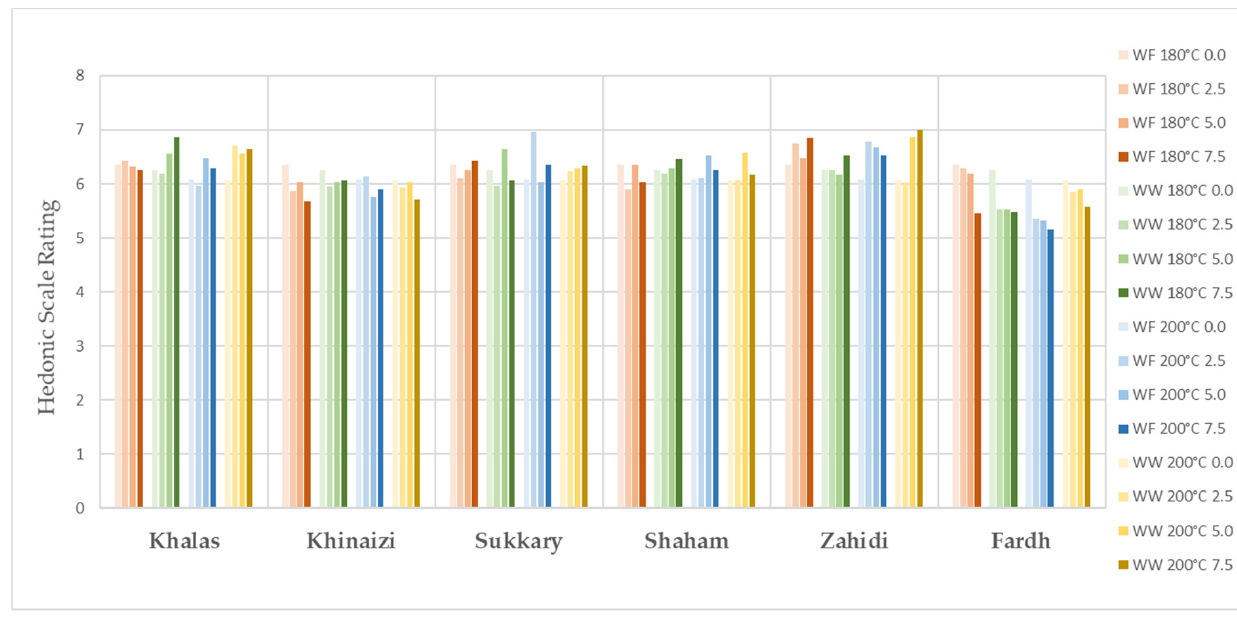
Figure 1. Smell evaluation for date seed composite cookies.